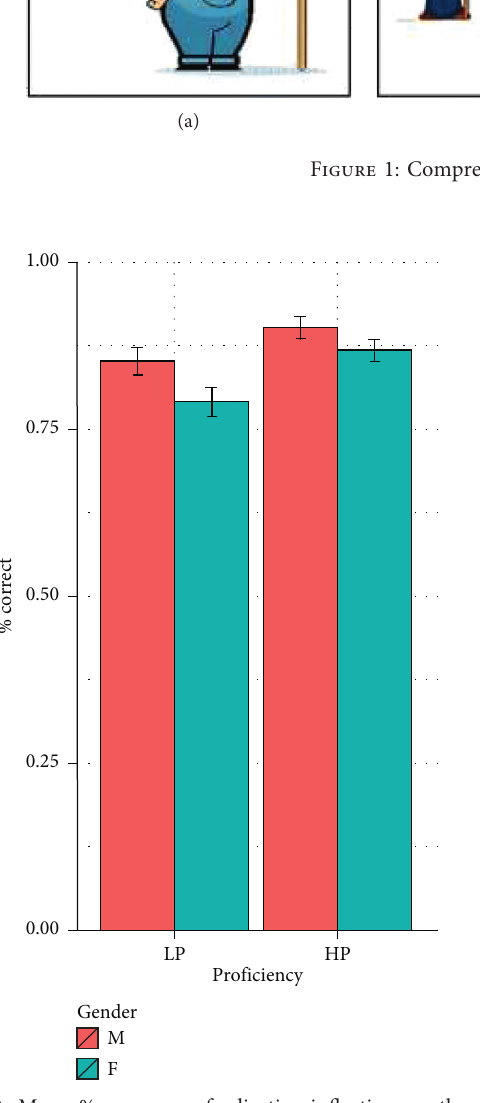
Figure 2: Mean % accuracy of adjective inflection on the pro- duction task, by proficiency and gender across proficiency groups.